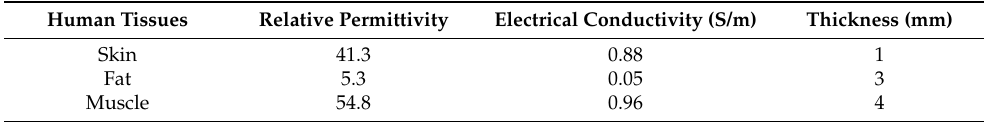
Figure 25. Simulated and measured 2D radiation patterns of the AMC-backed antenna in free space: ( a ) at 2.45 GHz (E plane); ( b ) at 2.45 GHz (H plane); ( c ) at 5.8 GHz (E plane); ( d ) at 5.8 GHz (H plane). Table 4. Properties of different human tissue layers